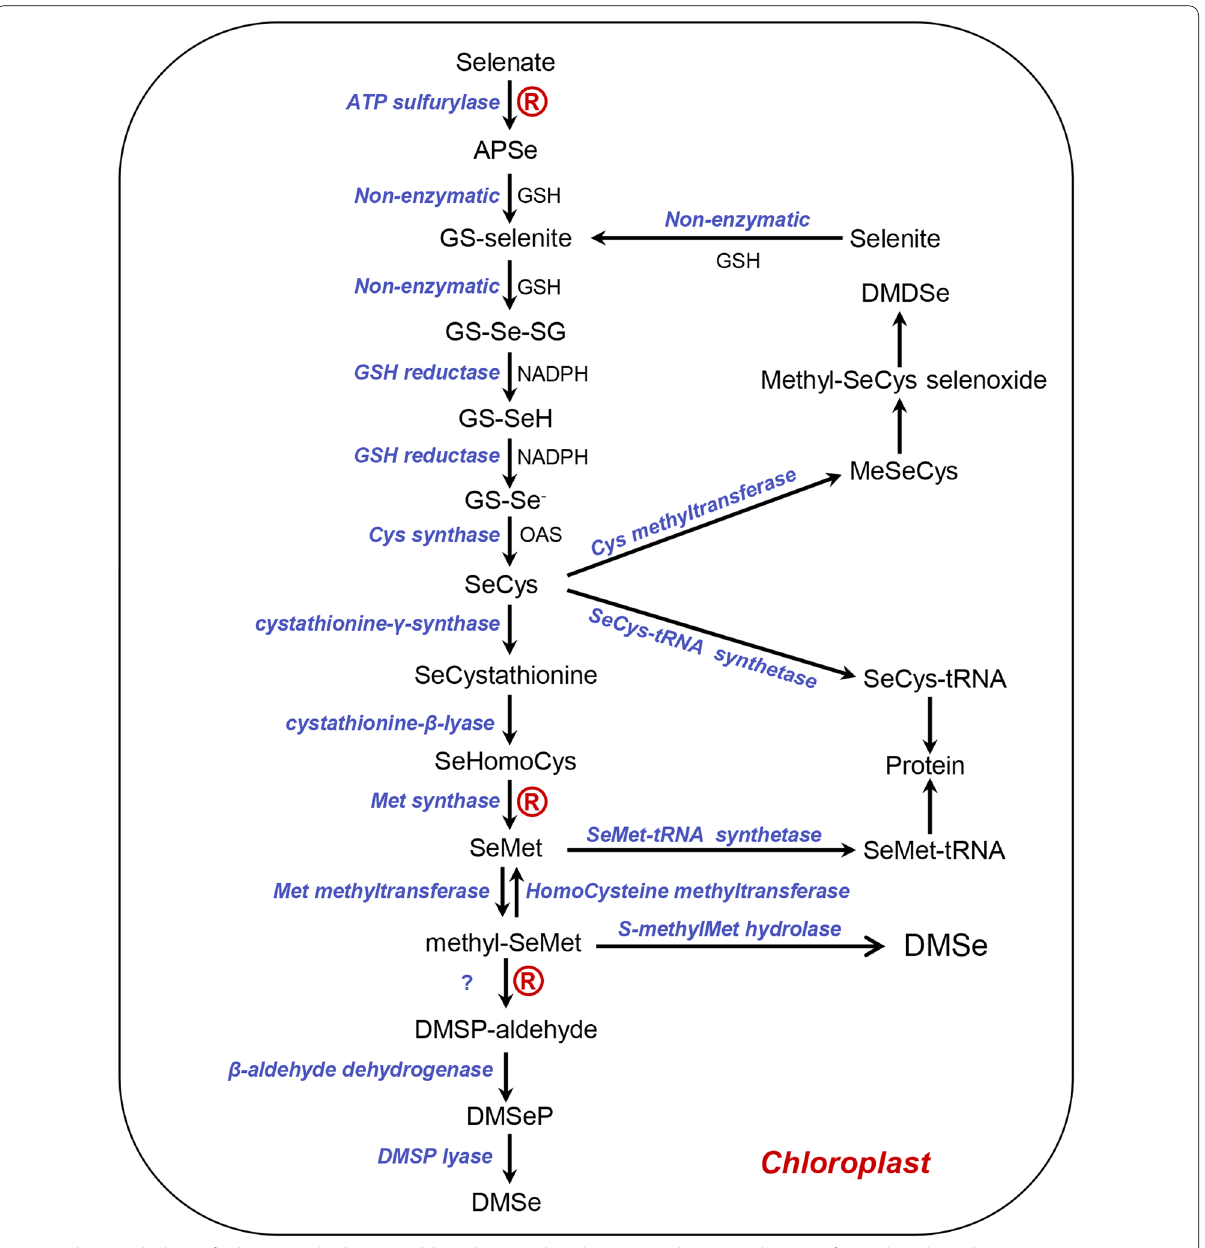
Fig. 2 The metabolism of selenate and selenite in chloroplasts or plastids (Terry et al. 2000). Selenate is first reduced to adenosine 5-phosphoselenate (APSe) by ATP sulfurylase (EC: 2.7.7.4) and then further reduced nonenzymatically to GSH-conjugated selenite (GS-selenite). Selenite is also reduced nonenzymatically to GS-selenite. The GS-selenite is reduced to selenodiglutathione (GS-Se-SG) by GSH, and GS-Se-SG is further reduced to selenol (GS-SeH) by NADPH and subsequently to GSH-conjugated selenide (GS-Se − ) by GSH reductase. SeCys is synthesized from GS-Se − and O-acetylserine catalyzed by Cys synthase. SeMet may be synthesized from SeCys via SeCystathionine and SeHomoCys catalyzed by cystathionine-γ-synthase, cystathionine-β-lyase, and Met synthase. SeCys is methylated to methyl-SeMet by Cys methyltransferase. SeMet is methylated to methyl-SeMet, and is further converted into dimethylselenonium propionate (DMSeP) by DMSeP lyase, and then cleaved to DMSe by S-methylMet hydrolase and volatilized. R represents the rate-limiting